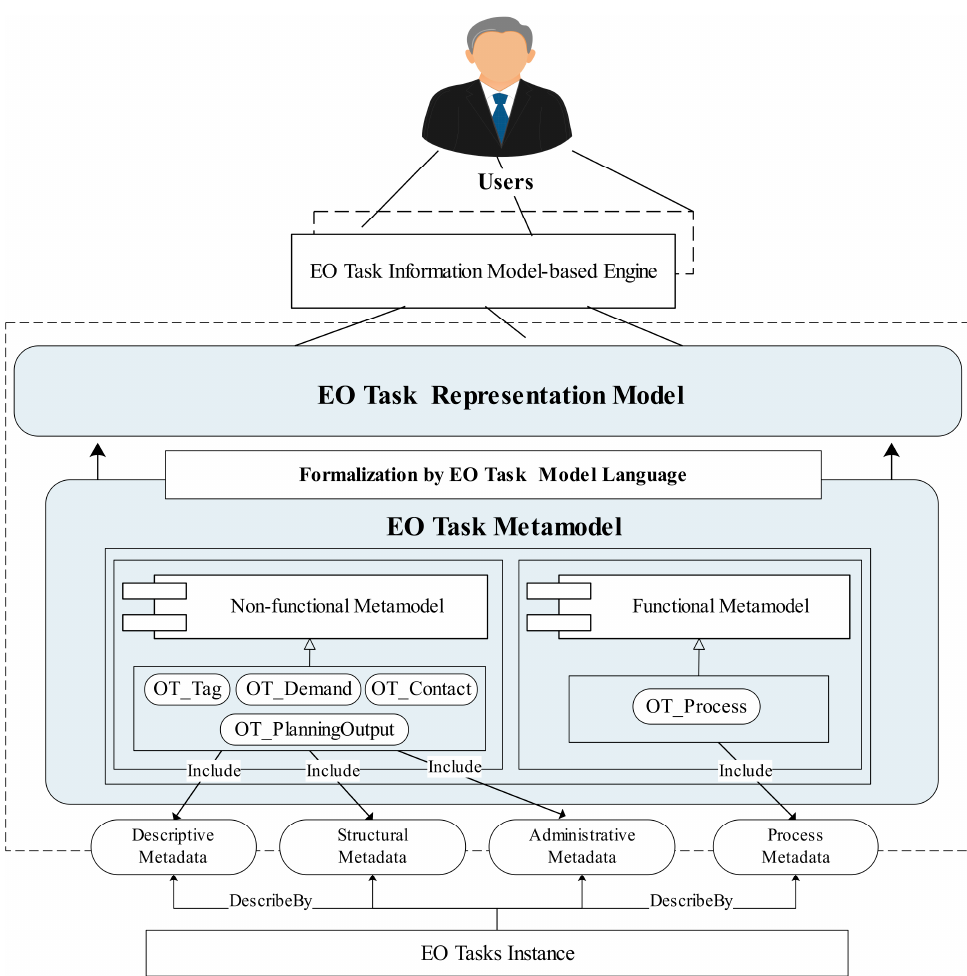
Figure 1. Metamodel framework of earth observation task representation. EO task instances are represented at multiple levels by corresponding speci fi c metadata collection types. A standard representation model of the EO task is constructed based on the EO task metamodel.